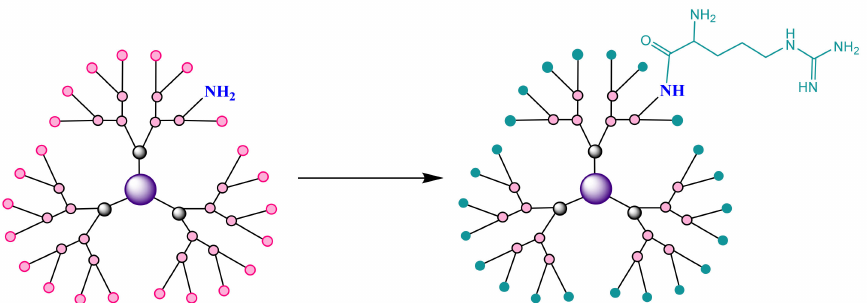
Figure 11. Conjugated PAMAM dendrimer with arginine to enhance siRNA delivery. Adapted from [225], published by Bioconjug Chem, 2014.